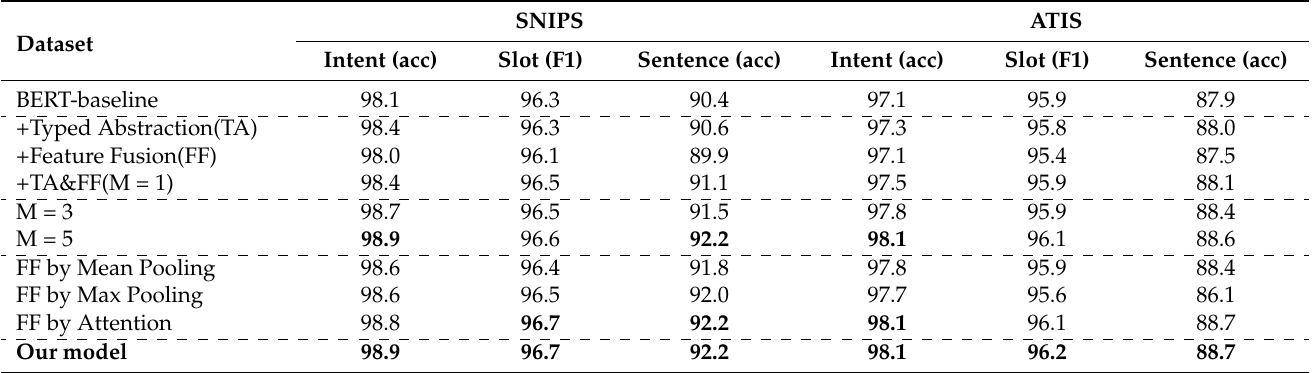
Table 5. Results of the ablation